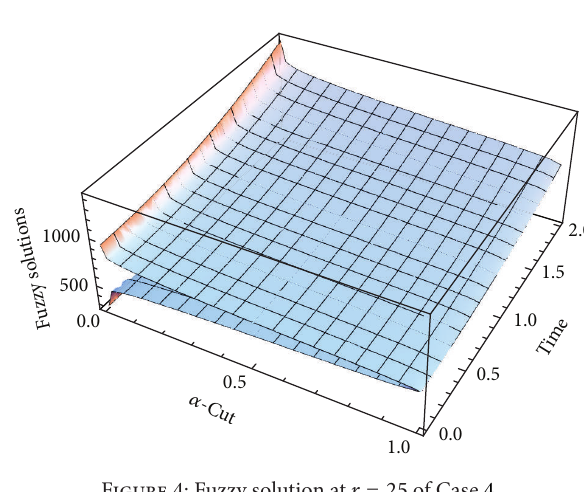
Figure 4: Fuzzy solution at 𝑟 = 25 of Case 4.